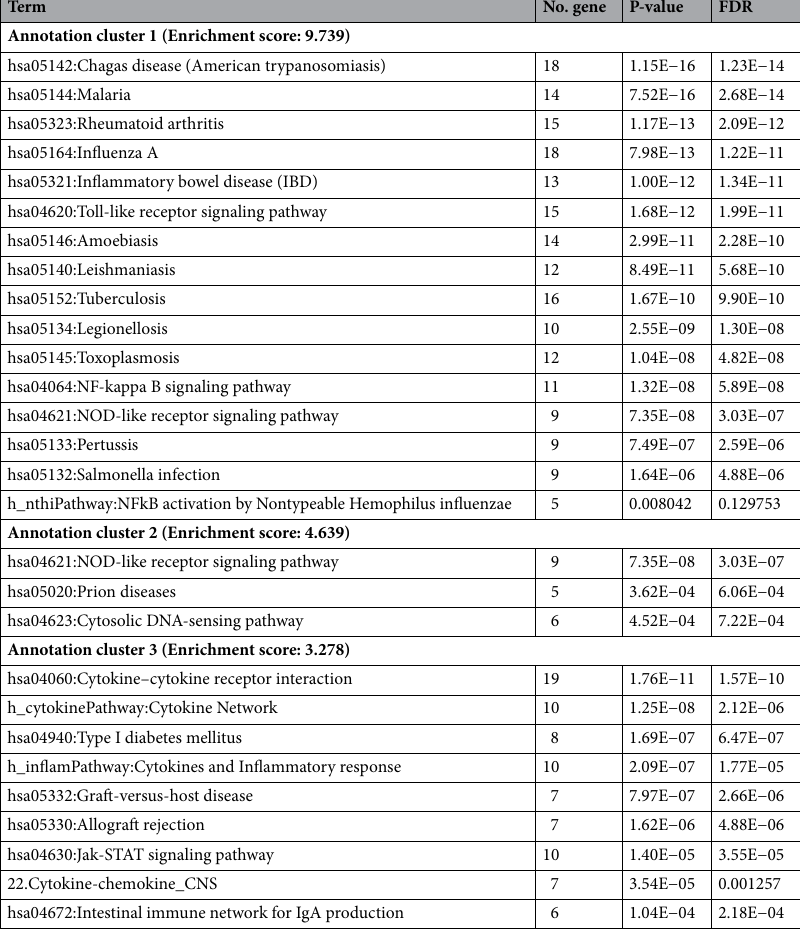
Table 7. Some of the significantly enriched pathways that are related to COVID-19 essential proteins ( E 1